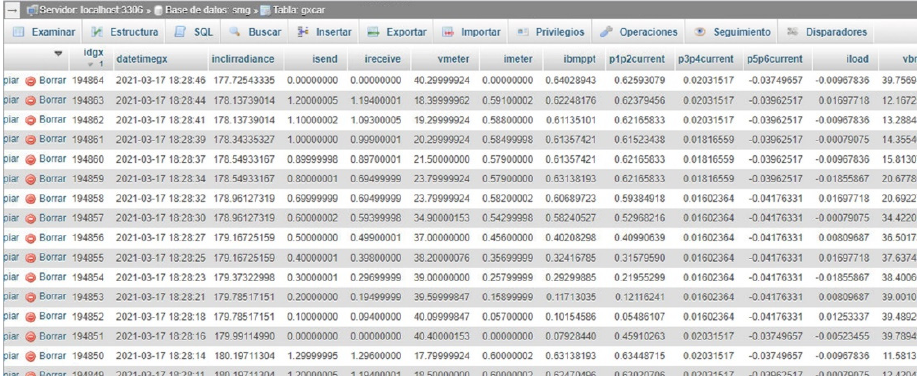
Figure 6. Data taken during characterization of PV modules.